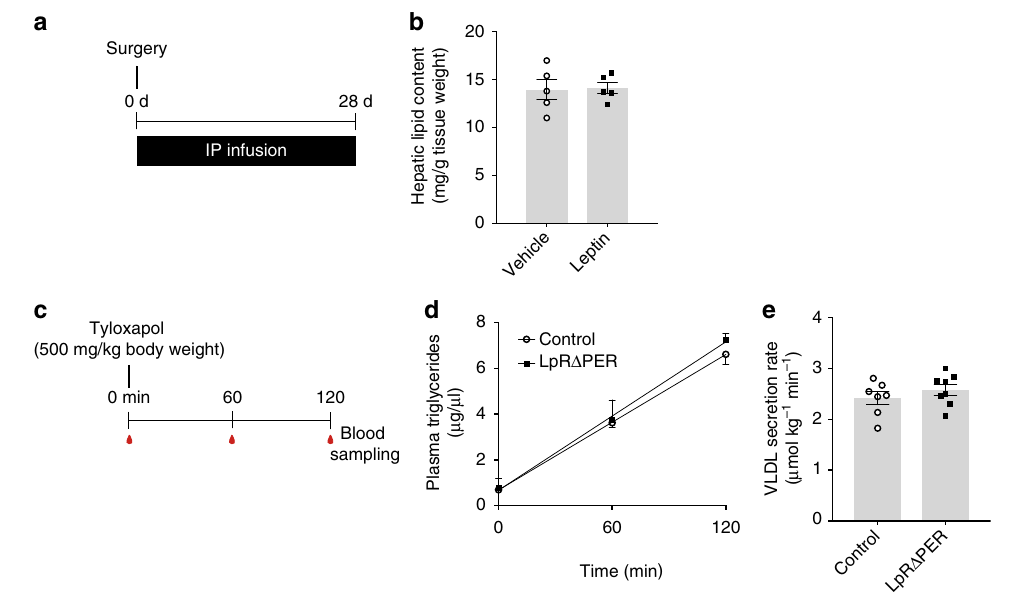
Fig. 2 Leptin effects on hepatic lipid metabolism are centrally mediated. a Protocol for chronic IP leptin infusion in rats (Leptin: 0.3 µ g/day; same dose used in the ICV experiments; Fig. 1f). b Hepatic lipid content after 28 days IP leptin/vehicle infusion ( n = 5 per group). c Protocol for tyloxapol infusion experiments in tamoxifen-inducible LpR Δ PER and control mice. d Plasma TG accumulation after a tyloxapol bolus in 6 h-fasted LpR Δ PER and controls ( ≥ 7 per group). e Hepatic VLDL secretion rate calculated from the slope in Fig. 2d. All data are mean ± SEM; no signi fi cant differences observed between leptin and control by two-tailed Student ’ s t test; ( b ) open circles: IP vehicle; black squares: IP leptin; ( d , e ) open circles: controls; black squares: tamoxifen- inducible leptin receptor knockout (LpR Δ PER)